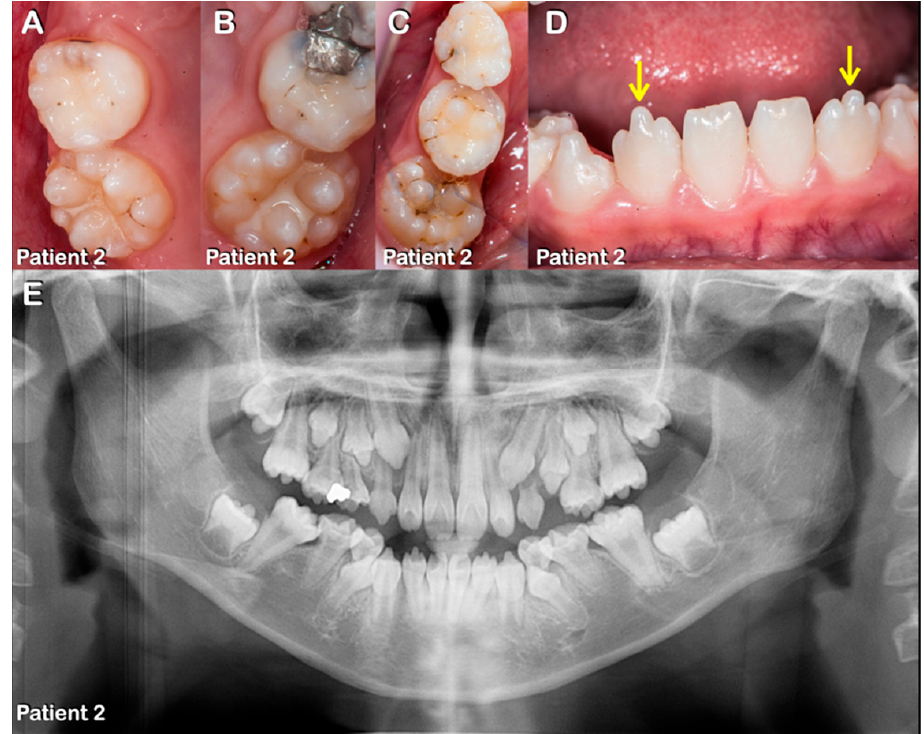
Figure 2. Patient 2. ( A – E ) Mixed dentition. ( A – C ) Round-shaped primary and permanent molars with multiple supernumerary cusps. ( D ) Prominent medial mamelon of the mandibular lateral permanent incisors (arrows). ( E ) Panoramic radiograph showing agenesis of all third permanent molars, single-rooted primary and permanent molars, and taurodontism.